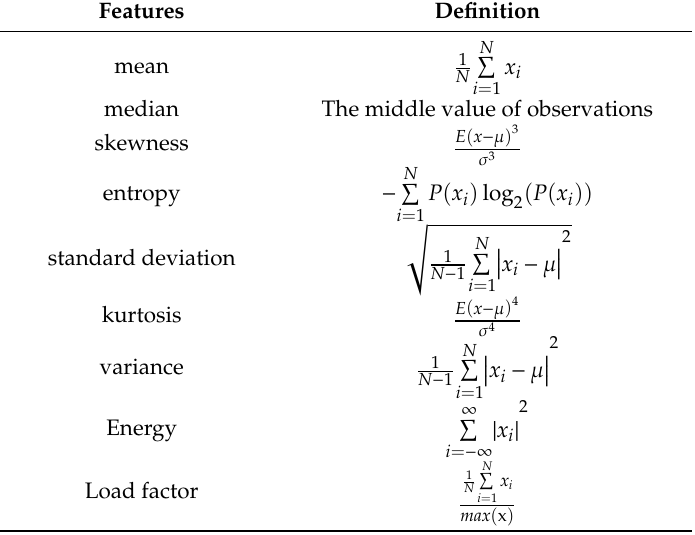
Figure 3. Block diagram of the proposed power theft classification model. Table 3. Definition of the classification features necessary to be extracted from the electricity consumption data.